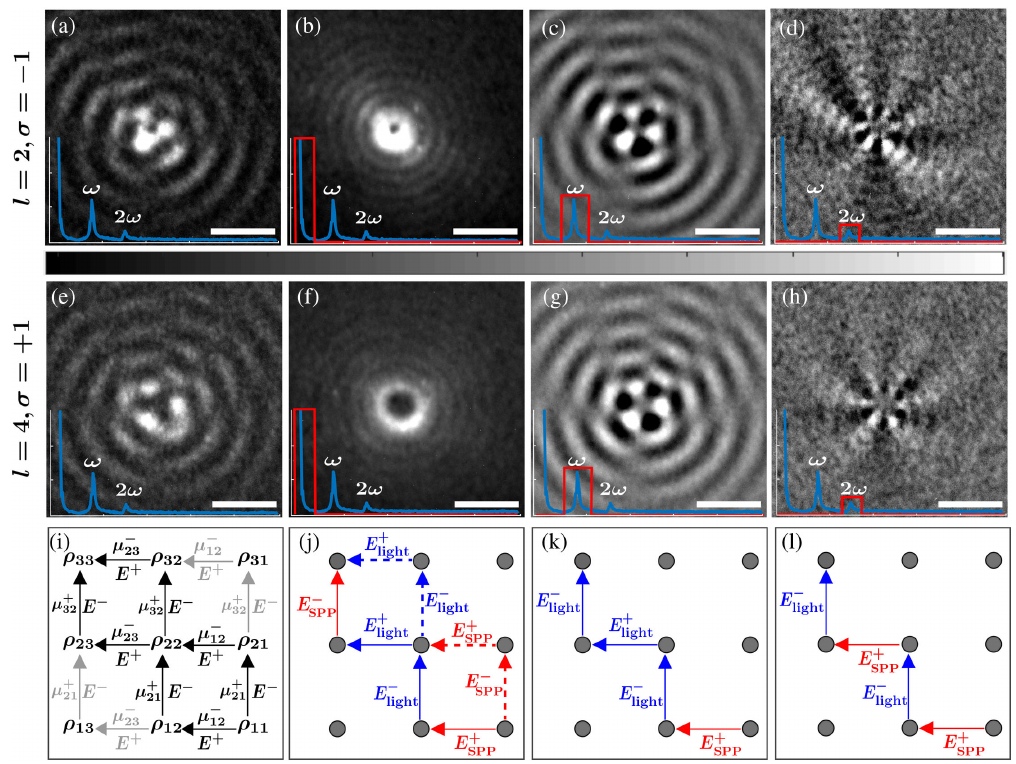
FIG. 5. Delay-time frequency decomposition of the experimental data. Demonstration of two interaction scenarios: l ¼ 2 , σ ¼ − 1 [(a) — (d)] and l ¼ 4 , σ ¼ þ 1 [(e) — (h)]. The raw experimental data at Δ t ¼ 63 . 2 fs (a,e) shows three azimuthal lobes with different radial distributions. The spectrum of a sample pixel Δ t data (blue trace) shows three distinct peaks. Filtering the data about these peaks (red schematic) results in the zero-frequency terms (b,f), as well as the dynamic first-order (c,g) and second-order (d,h) light- plasmon angular-momentum mixing terms. The scale bar is 2 microns. For full movies, see the SM [40]. (i) — (l) Visualization of the possible quantum pathways in a three-level density matrix corresponding to the decomposed data components. (i) The four-step two- photon absorption process occurring either through the intermediate-state population (black arrows) or via off-diagonal elements (greyed arrows). Example excitation pathways of (j) nonmixing (dashed arrows) and nonoscillating double mixing, (k) single mixing, and (l) double mixing, corresponding to (b,f), (c,g), and (d,h),